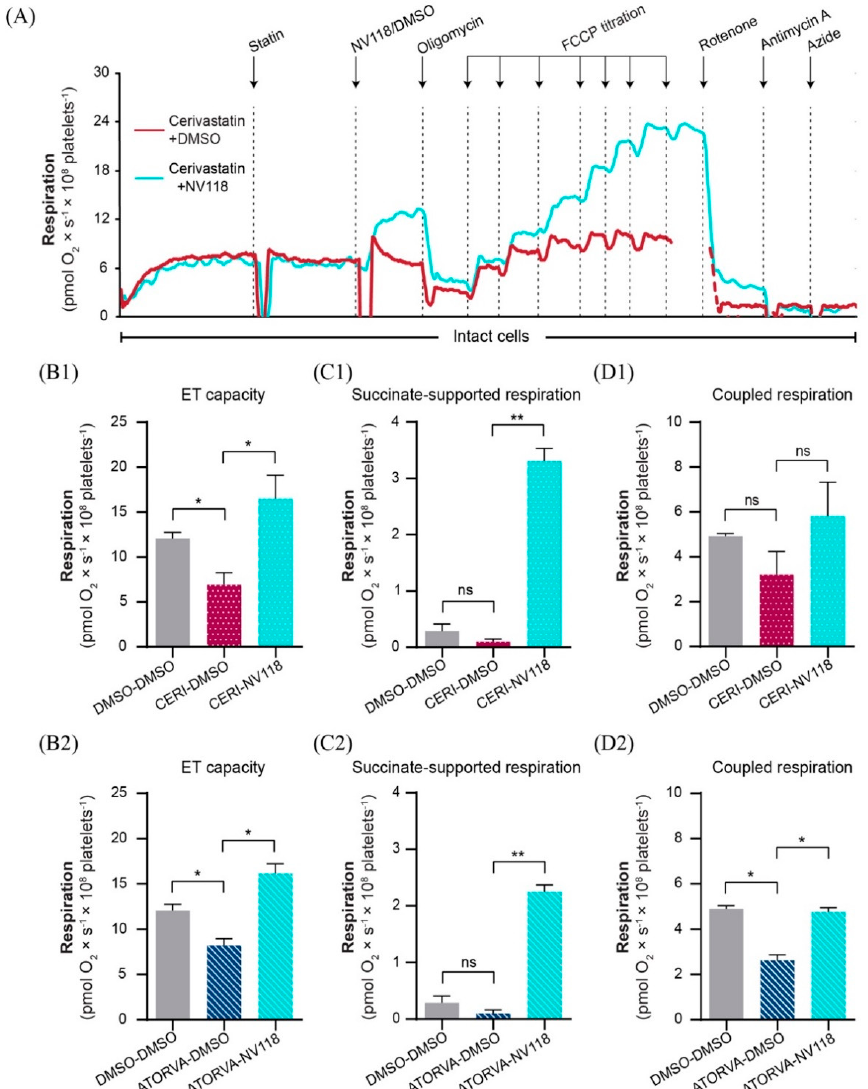
Figure 4. The effects of NV118 on statin − dependent respiratory dysfunction in human platelets. ( A ) Representative overlay trace of statin-exposed platelets in the absence (red) or presence (blue) of the succinate prodrug NV118. NV118 effects in cerivastatin ( B1 , C1 , D1 ) and atorvastatin ( B2 , C2 , D2 ) exposed platelets were measured as compared to its vehicle (DMSO). As negative control of the experiment, platelets were exposed only to DMSO (DMSO-DMSO). Data is expressed as mean ± SEM. One-way ANOVA with Bonferroni post hoc test was performed on antimycin-corrected data. ATORVA, atorvastatin; CERI, cerivastatin; DMSO, dimethyl sulfoxide; ET, electron transport. ns = no significance; * p < 0.05; ** p < 0.01.